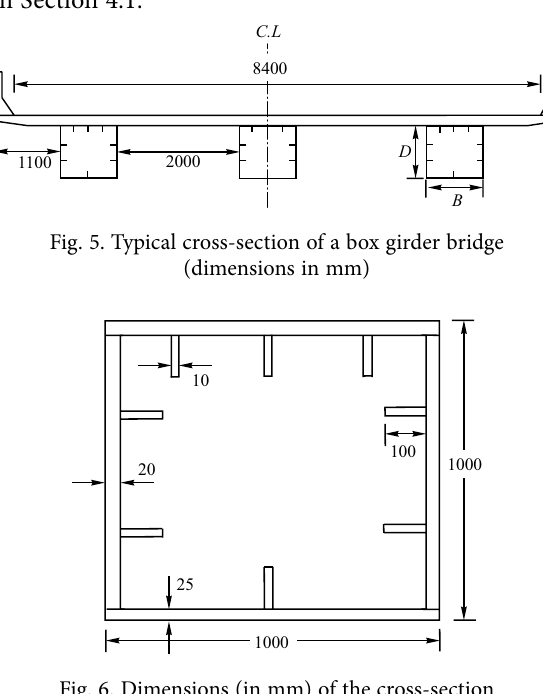
Fig. 6. Dimensions (in mm) of the cross-section of the box girder Table 2. Values used in the